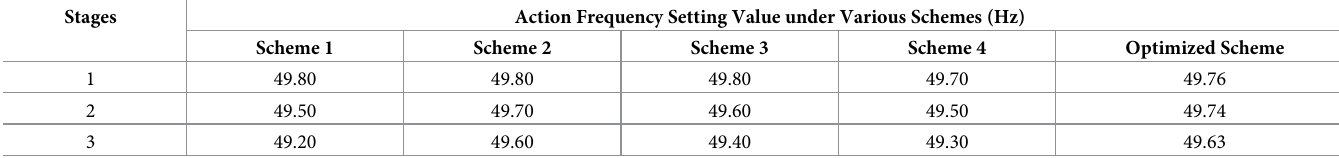
Table 4. Comparison of five different schemes.